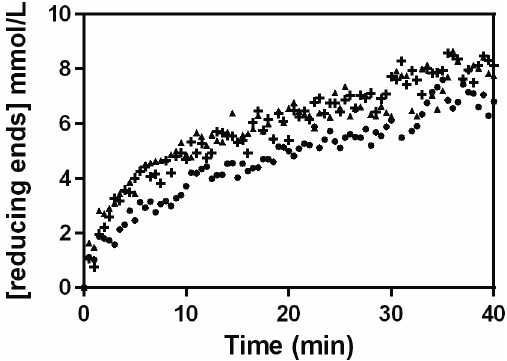
Figure 2. Reaction profiles obtained over the first 40 min at different temperatures. The hydrolysis was performed using 0.5% N (m/v) pectin, with the pectinase complex produced by Aspergillus niger ) 30 u C, ( m ) 40 u C and ( + ) CH4 in solid-state fermentation. Symbols: ( 50 u C.